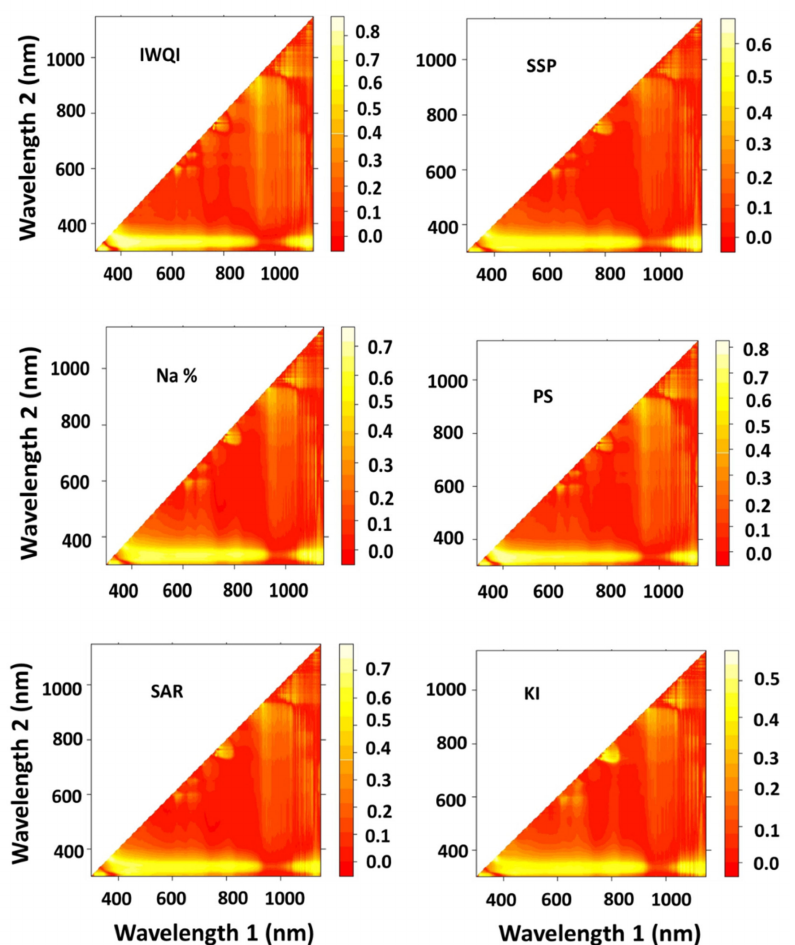
Figure 4. Contour maps of coe ffi cients of determination (R 2 ) between all dual wavelength combinations in the range of 302–1148 nm as a spectral ratio index and each of the irrigation water quality indicators (IWQIs): irrigation water quality (IWQ), percent sodium (%Na), sodium absorption ratio (SAR), soluble sodium percentage (SSP), potential salinity (PS), and Kelly’s index (KI). The contour maps were established based on the combined spectral reflectance data of groundwater samples from two regions ( n =